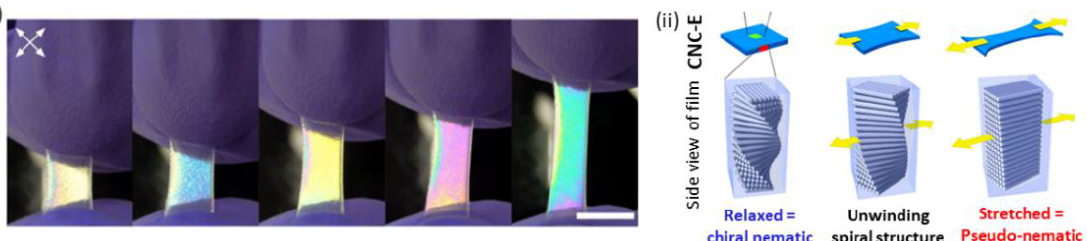
Figure 11. Photographs of CNC-E stretching viewed under crossed polarizers (i), with color changes from white to blue to yellow to pink to green upon stretching, and (ii) schematic illustration of reorientation of CNCs from chiral nematic to a pseudo-nematic structure as the film is stretched [158]. Copyrights: all the images have been adapted and reproduced with permission from © 2019, Osamu Kose et al., published by Springer Nature.